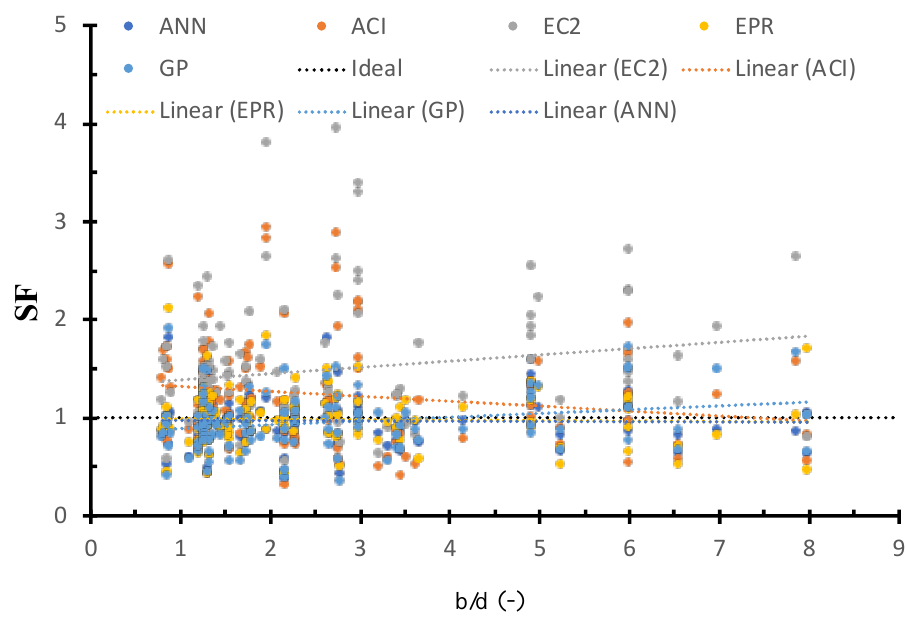
Figure 11. SF calculated using various models versus 𝑏 𝑑⁄ .